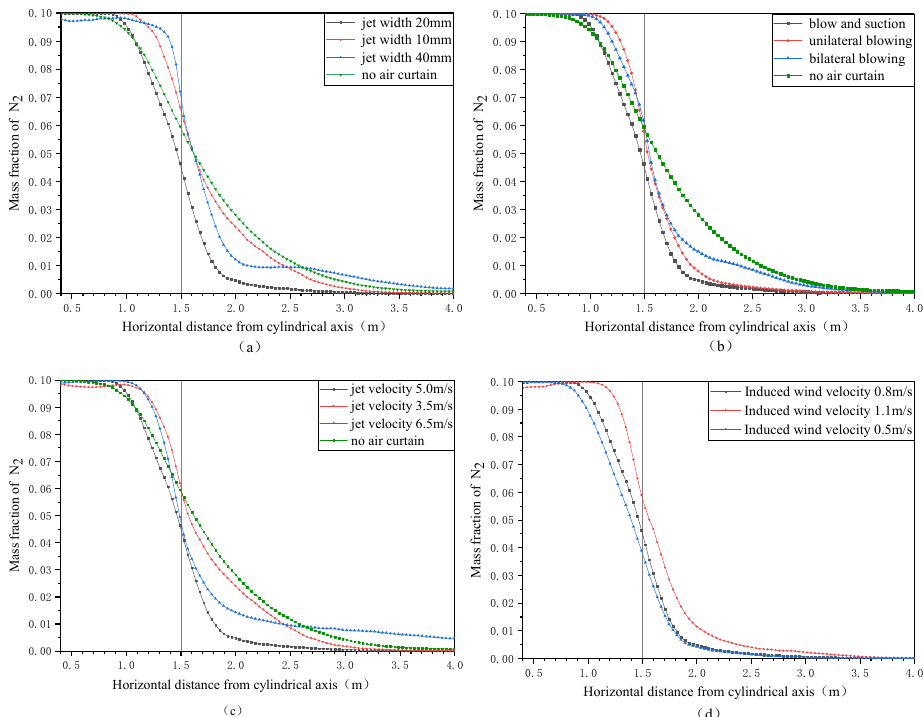
Figure 15. The pollutants’ mass fraction at the horizontal distance from the cylindrical axis: ( a ) jet width (blow and suction; 20 mm–10 mm–40 mm; 5 m/s; 0.8 m/s); ( b ) air curtain jet mode (blow and suction, unilateral blowing, bilateral blowing; 20 mm; 5 m/s; 0.8 m/s); ( c ) jet velocity (blow and suction; 20 mm; 5 m/s–3.5 m/s–6.5 m/s; 0.8 m/s); ( d ) induced wind velocity (blow and suction; 20 mm; 5.0 m/s; 0.8 m/s–1.1 m/s–0.5 m/s).